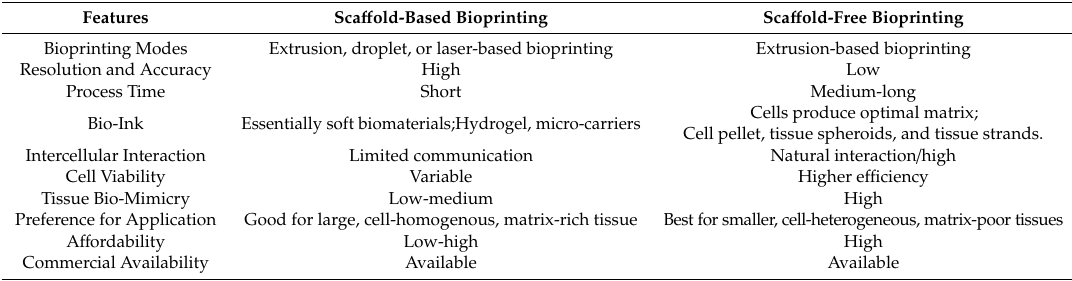
Table 3. Comparison between sca ff old-free bioprinting and sca ff old-based bioprinting [39].